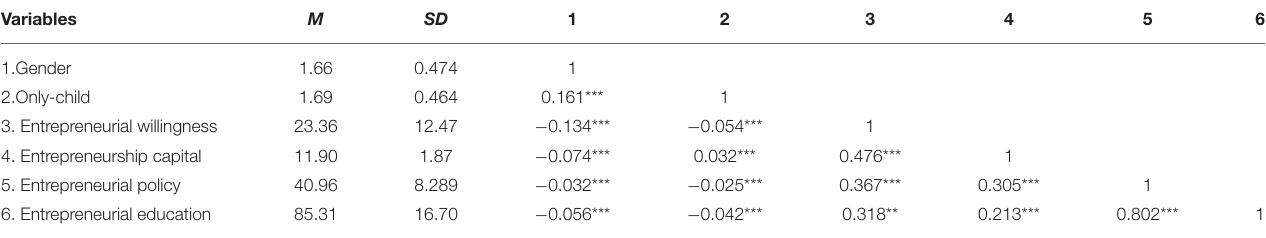
TABLE 1 | Correlation matrix between entrepreneurial willingness and entrepreneurship capital, entrepreneurial policy, and entrepreneurial education satisfaction. Variables M